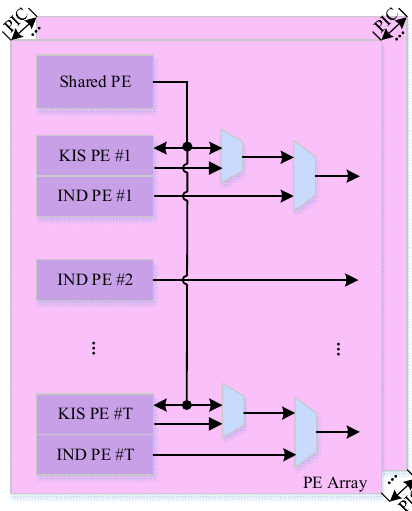
Figure 2. The architecture of the processing elements array.